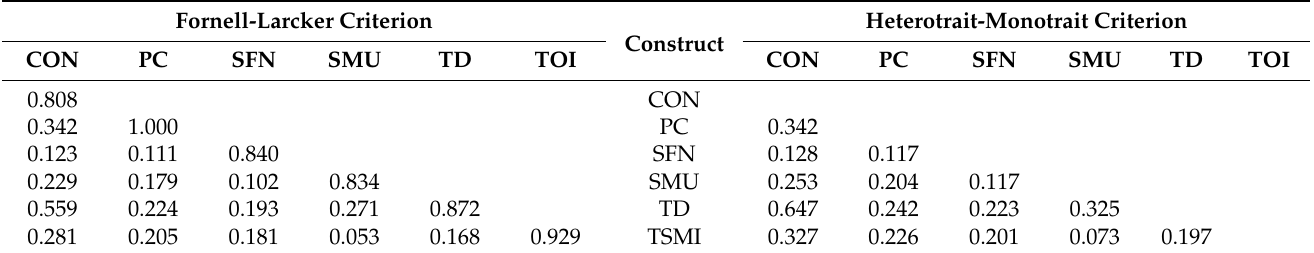
Table 3. Discriminant validity analyses.